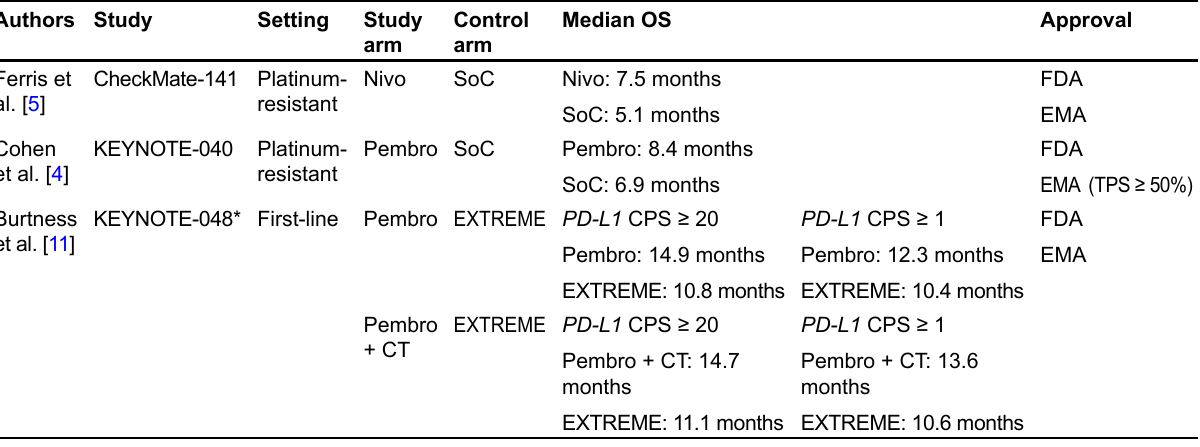
Table 1. Trials of approved checkpoint inhibitors for R/M HNSCC Authors